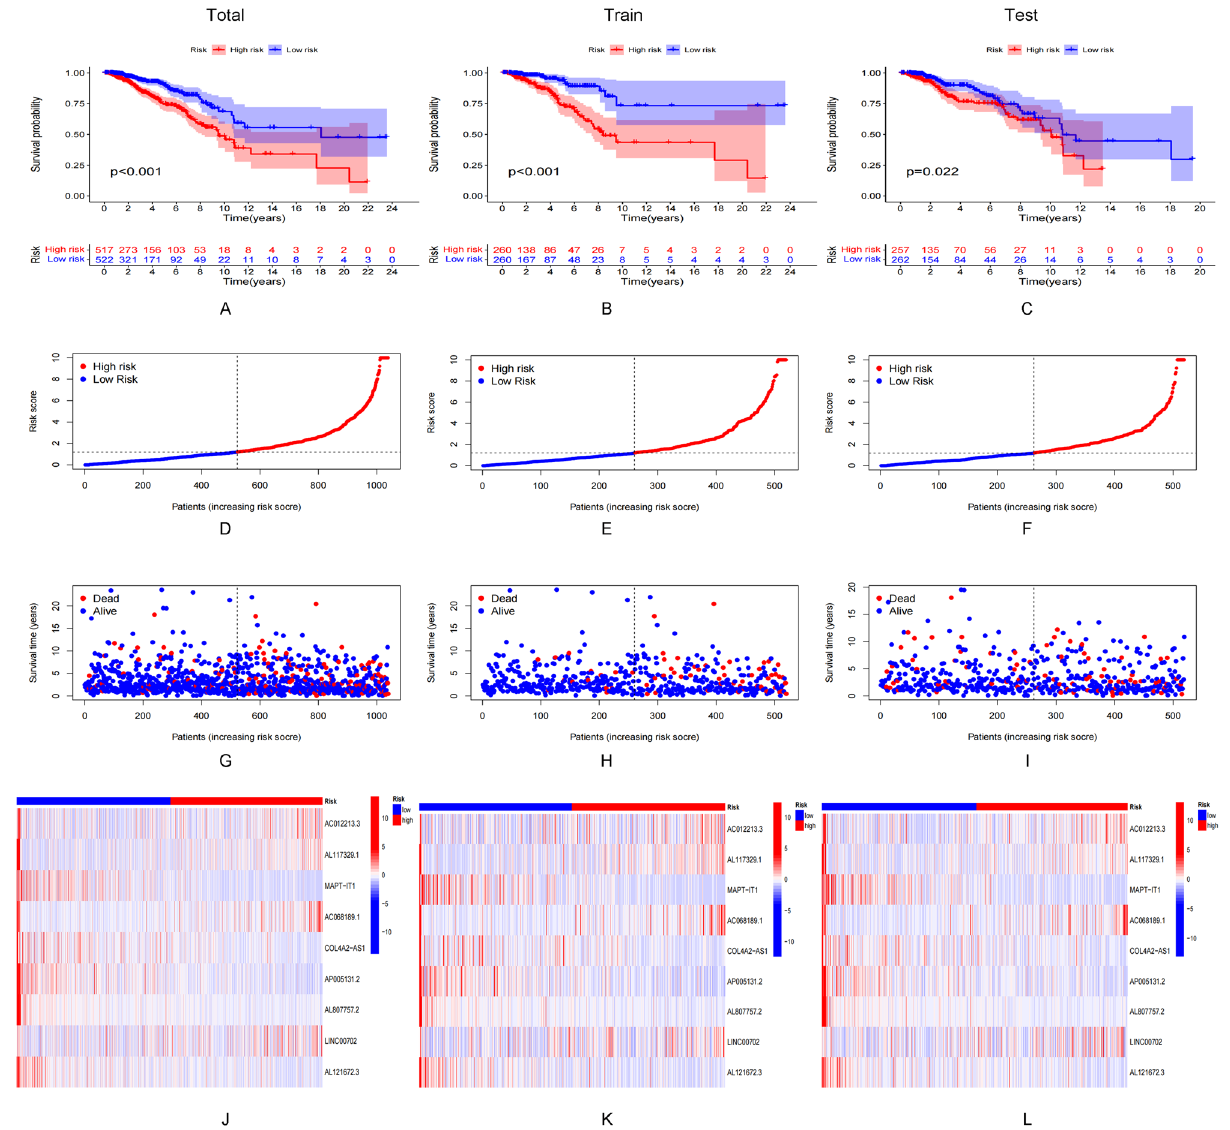
Figure 3. Prognostic value of 15 necrosis-associated lncRNAs models across the total dateset, training dateset, and validation dateset. ( A – C ) Kaplan–Meier survival curve based on OS (survival probability) of the total dateset, training dateset, and validation dateset. ( D – F ) Risk score for the otal dateset, training dateset, and validation dateset. ( G – I ) Survival time and survival status of the otal dateset, training dateset, and validation dateset of low- and high-risk groups. ( J – L ) Heat maps expressed by 9 lncrnas in the otal dateset, training dateset, and validation